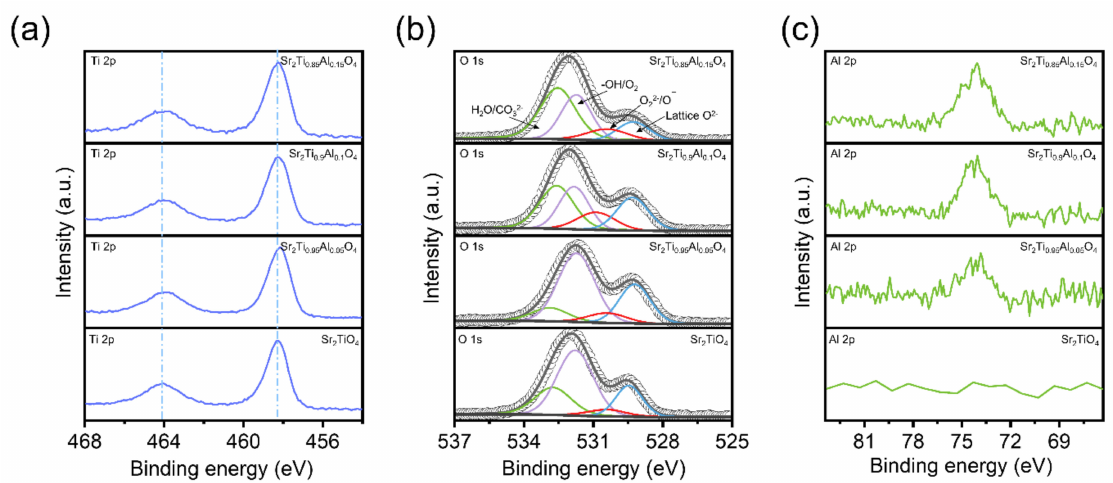
Figure 4. XPS spectra of Sr 2 Ti 1 − x Al x O 4 (x = 0, 0.05, 0.1, and 0.15): ( a ) Ti 2p, ( b ) O 1s, and ( c ) Al